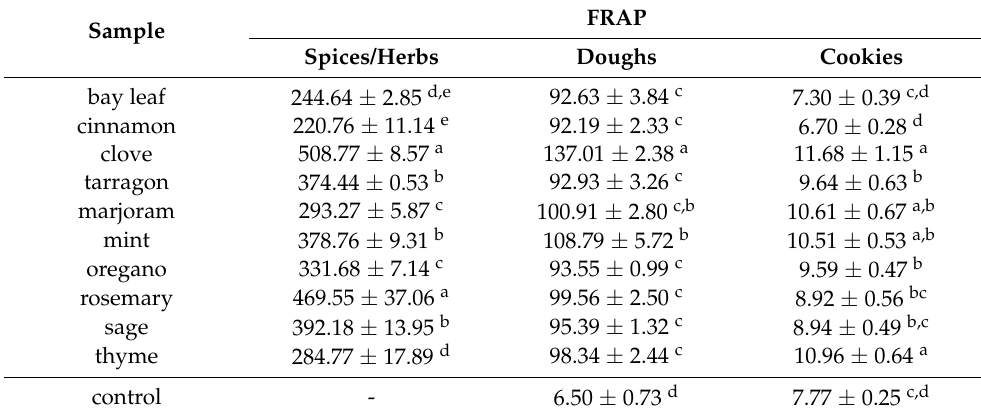
Table 3. Antioxidant activity measured with the FRAP method. Data presented as µ mol Trolox/g DM. Sample